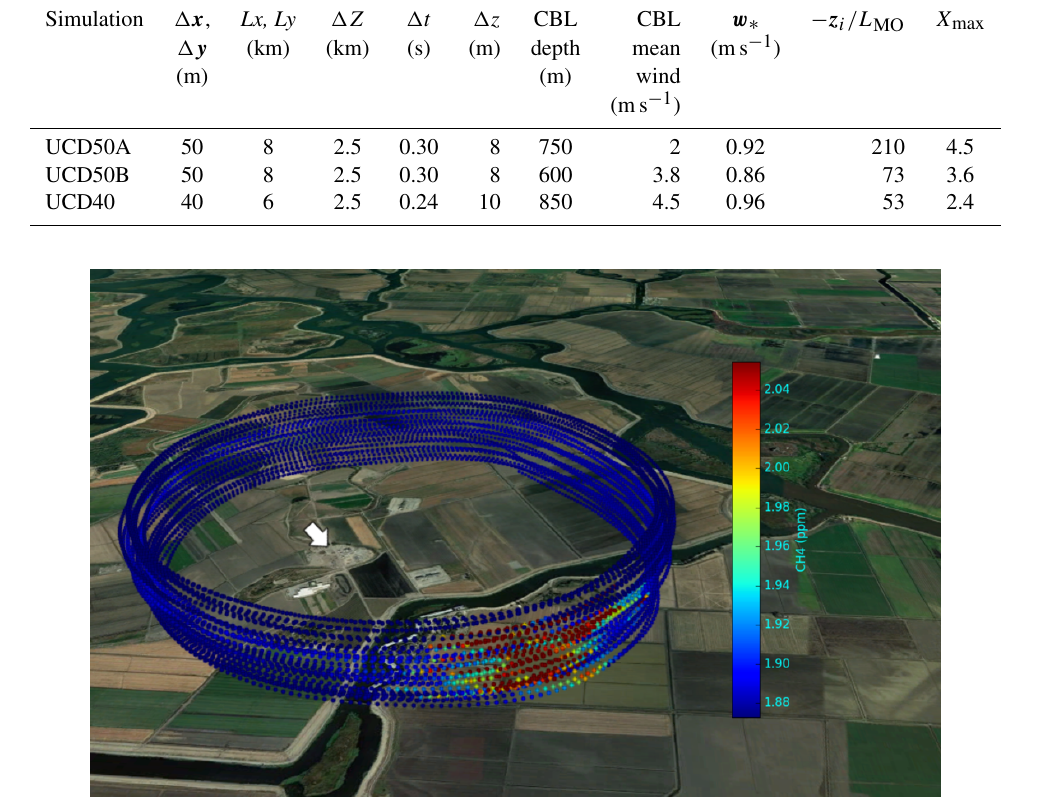
Figure 1. Map of the airplane flight pattern sampling a methane plume emanating from an underground storage facility. Wind direction is indicated by the white arrow and the methane mixing ratio is given by the color bar to the right. This flight was conducted on 28 June 2016 and took place between 12:46 and 13:52LT at altitudes ranging from 91 to 560m with a loop diameter of approximately 3km. The measured methane emission rate was 763 ± 127kgh − 1